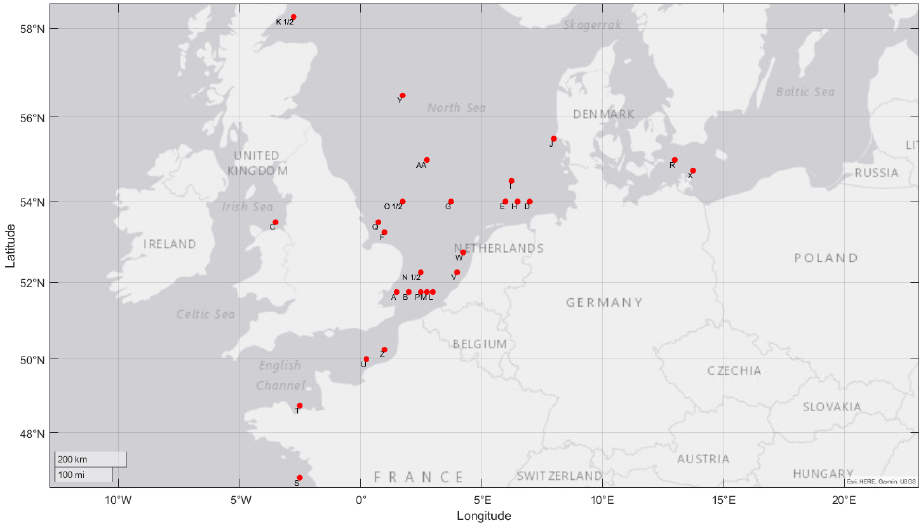
Figure 1. Map of Europe with locations of the 29 largest wind farms marked by red points. Large wind farms are mainly concentrated in the North